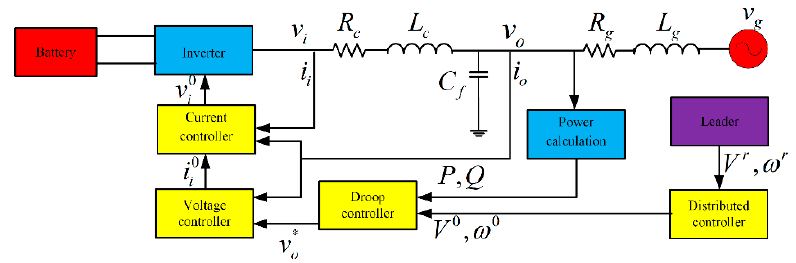
Figure 2. The hierarchical control structure of BESS.